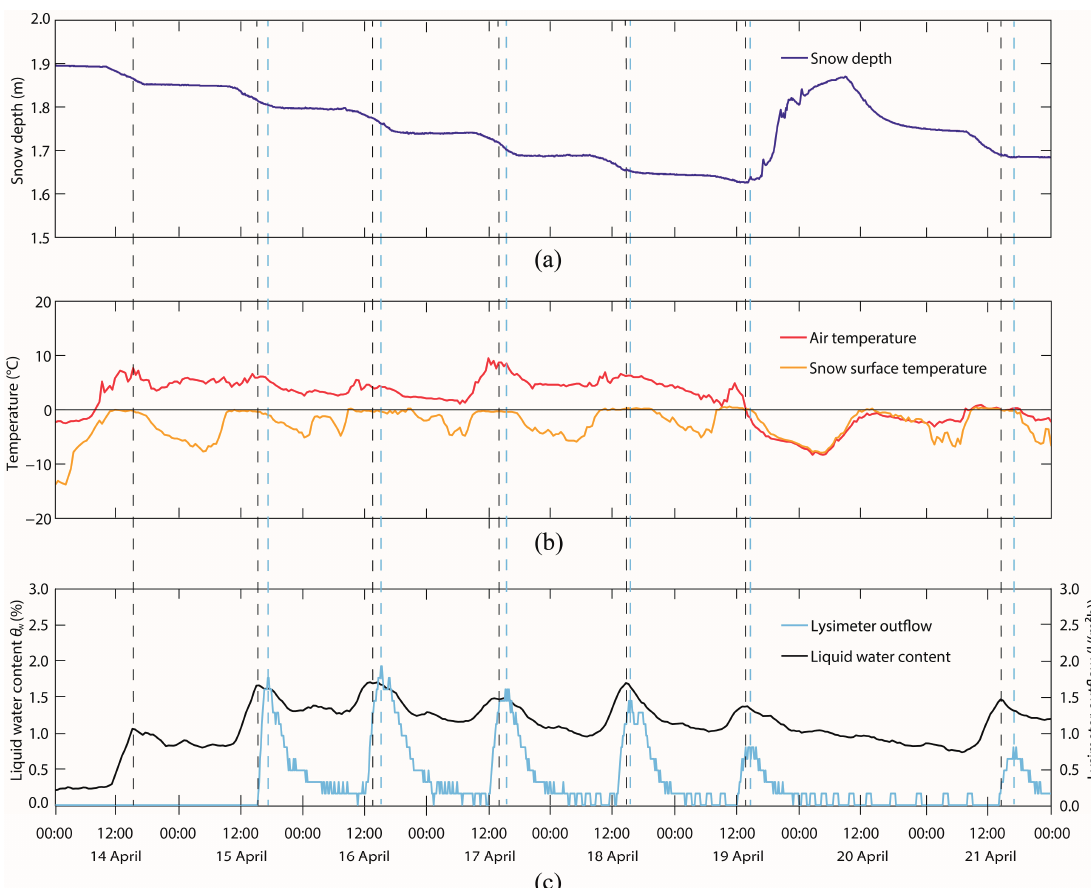
Figure 9. ( a ) Snow depth; ( b ) air and snow surface temperature and ( c ) lysimeter meltwater outflow, as well as the bulk volumetric LWC derived from normalized GPS C/N 0 measurements at the Weissfluhjoch test site during the time period 14–21 April 2013. Daily peaks of the lysimeter outflow and the LWC are marked with the dashed lines in corresponding